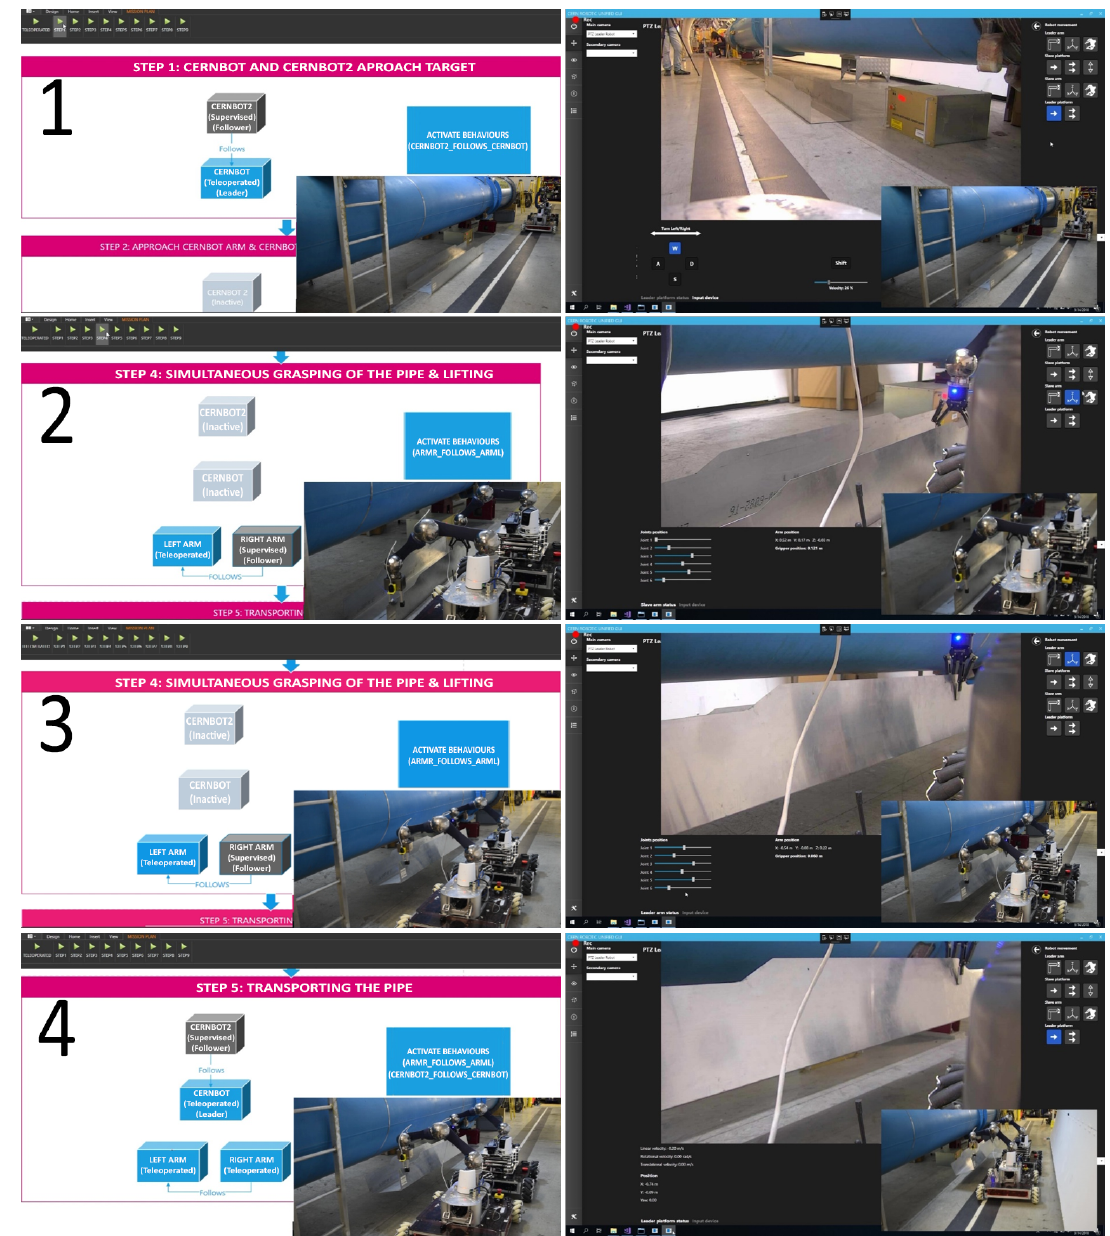
Figure 15. Mission plan sequence: ( 1 ) approaching the target, ( 2 ) grasping, ( 3 ) lifting, and ( 4 )